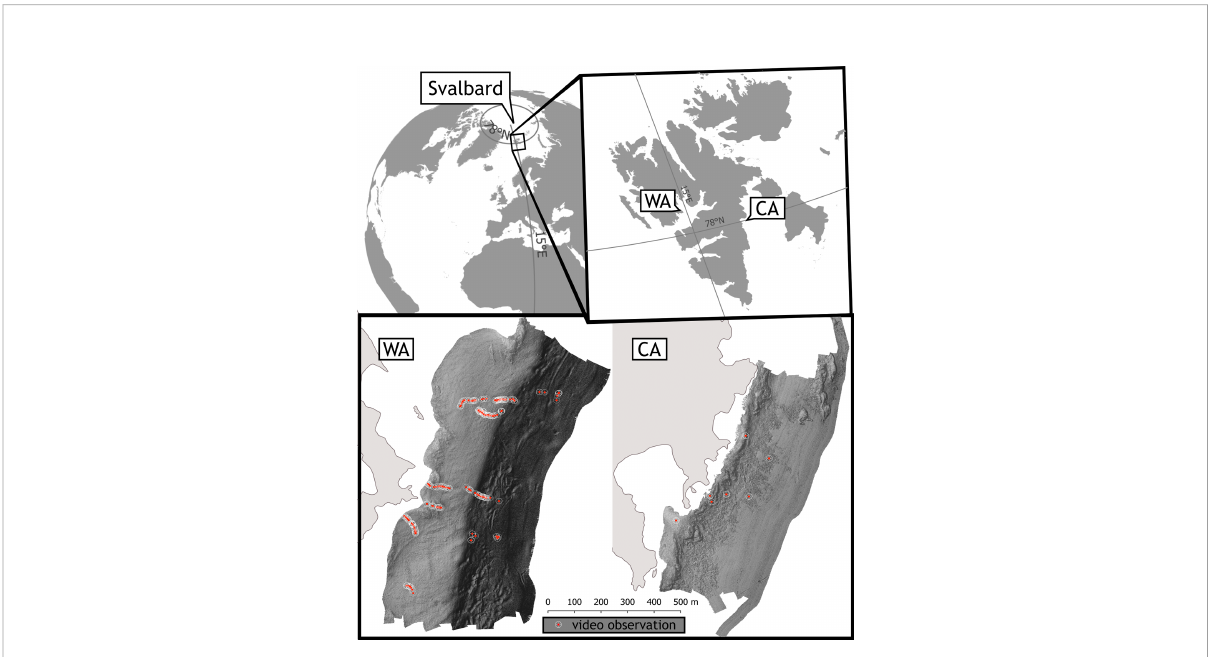
FIGURE 1 Localization of hydroacoustic study area and ground-truthing data (open circles) over reliefs of surveyed polygons in Isfjorden (Bohemanneset) in West Spitsbergen referred to as Warm Arctic (WA) and in Storfjorden (Agardhbukta) East Spitsbergen referred to as Cold Arctic (CA).